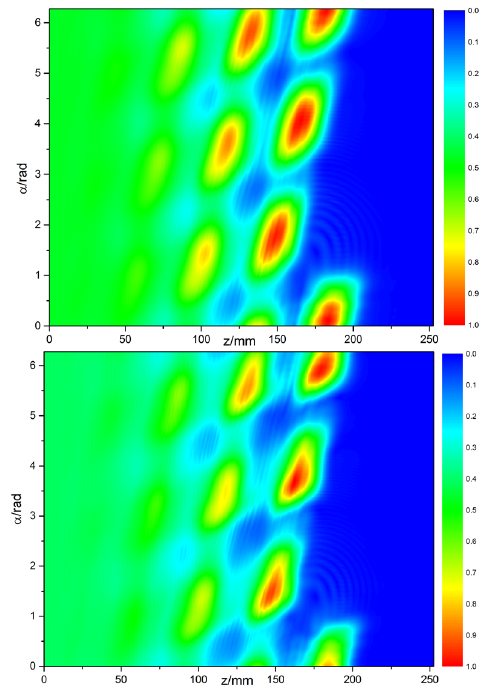
Fig. 5. Contours of the normalised amplitude of the electric field on the launcher surface for 140.0 GHz operation (top) and for 175.4 GHz operation